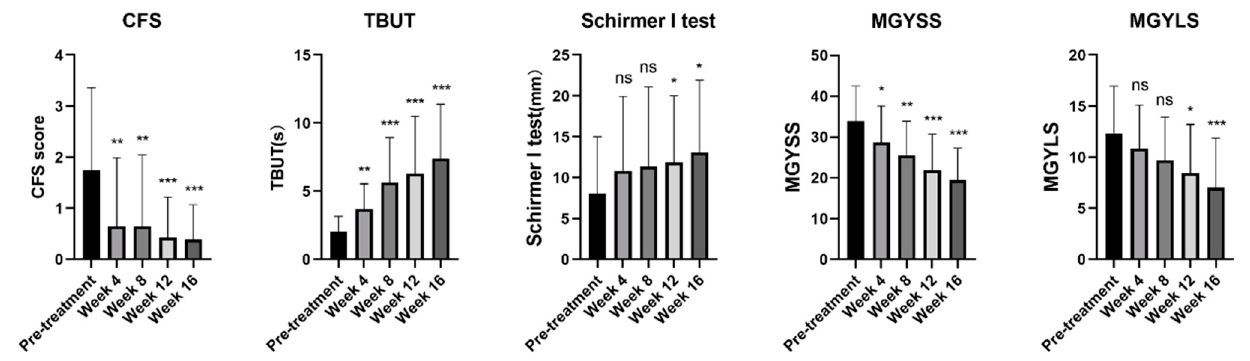
Figure 2. Changes of signs and examinations before and after treatment of IPL combined with DCBE